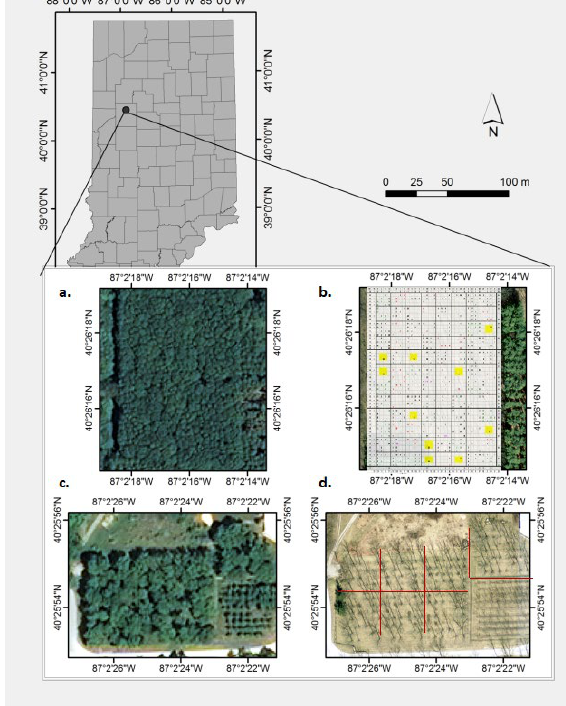
Figure 2. Aerial view of the study area. The top two aerial photos show the northern red oak stand during leaf-on ( a ) and leaf-off ( b ) seasons; a stem map was added to the leaf-off photo, to show the subplot blocks; the bottom two aerial photos show the black walnut stand during leaf-on ( c ) and leaf-off ( d ) seasons; red lines were added to the leaf-ff photo to show the subplot blocks (see more details in Section 2.2.).